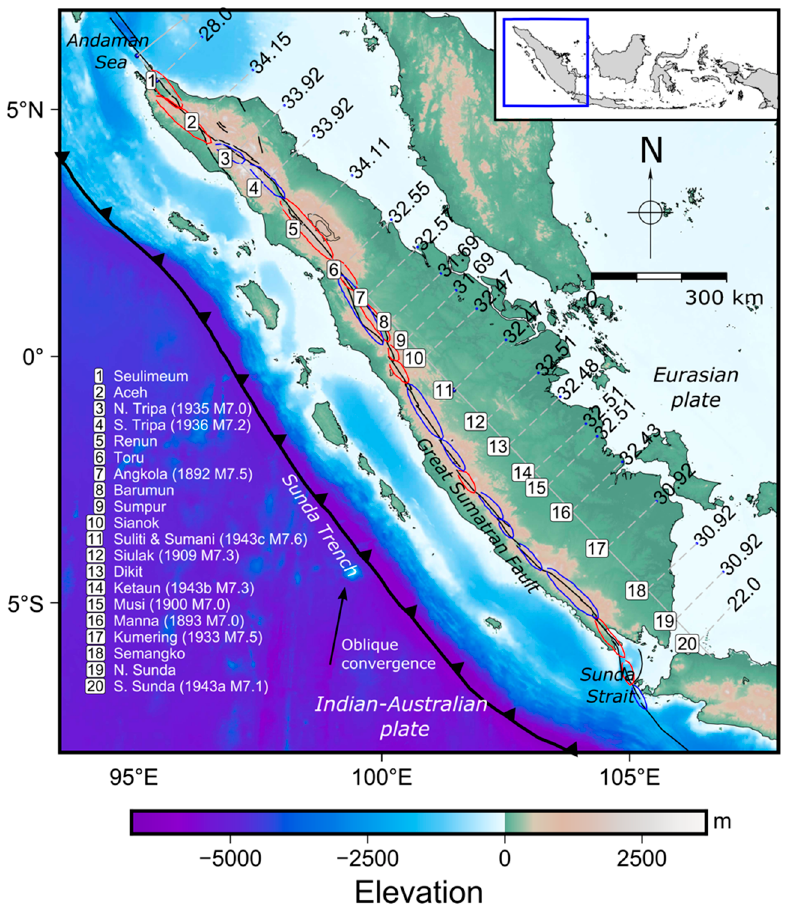
Figure 10. The variation in crustal depth along GSF based on CRUST1.0 model and the M ≥ 7.0 earthquake history since 1892[20]